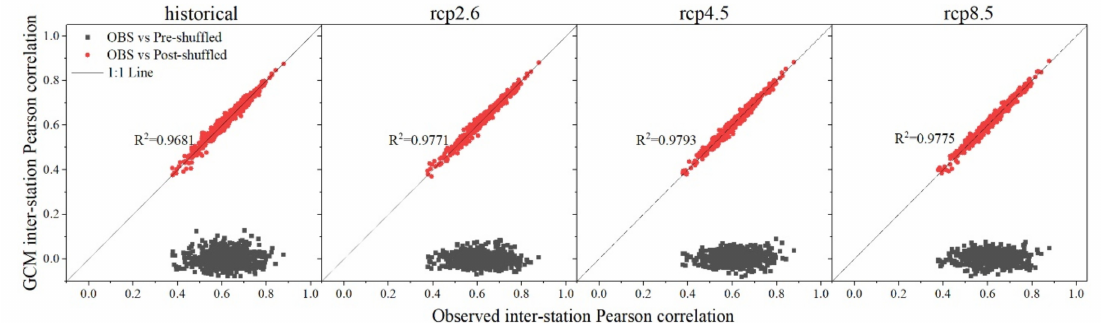
Figure 7. The inter-station Spearman rank correlation for observation (OBS), CLIGEN-generated single-site precipitation sequences (pre-shu ffl ed, without using shu ffl e procedure) and shu ffl ed precipitation sequences (post-shu ffl ed, using shu ffl e procedure) without adjusting the input correlation